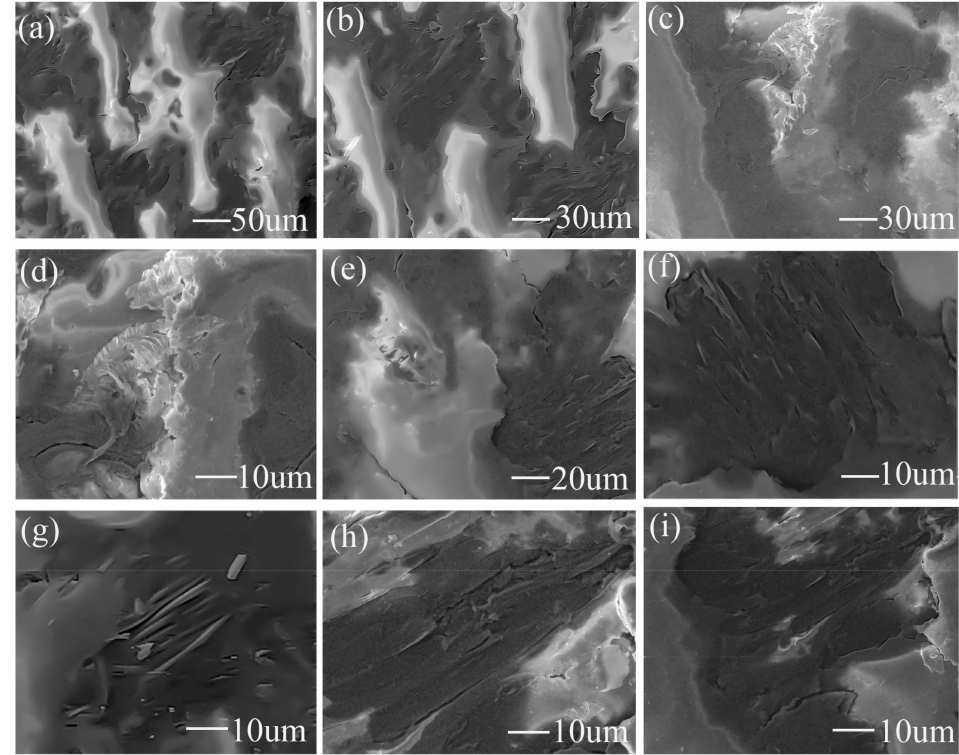
Figure 9. SEM images of the water-lubricated worn area after soaking, ( a ) surface morphology of the wear zone, ( b ) partially enlarged view of ( a ), ( c ) rolling wear zone of PTFE, ( d ) partially enlarged view of ( c ), ( e ) adhesive wear zone of PTFE, ( g ) Nomex fibers before wear, ( f , i ) Nomex fibers after wear and ( h ) partially enlarged view of ( i